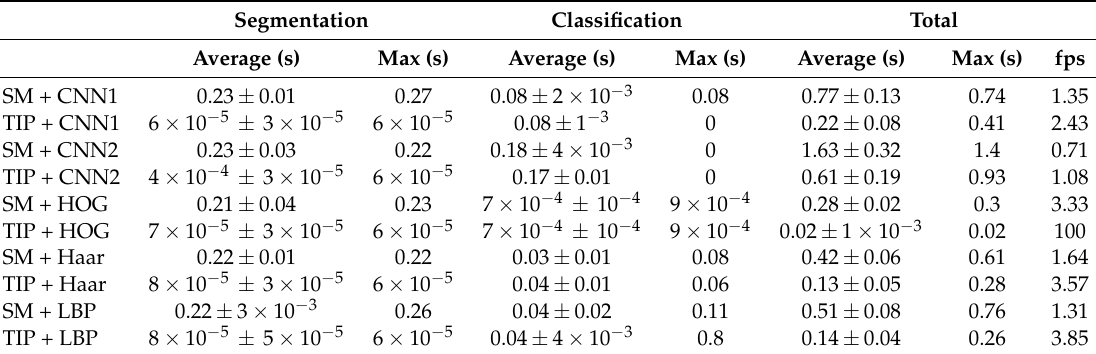
Table 8. Time estimation of PRS implementation in the MGCS